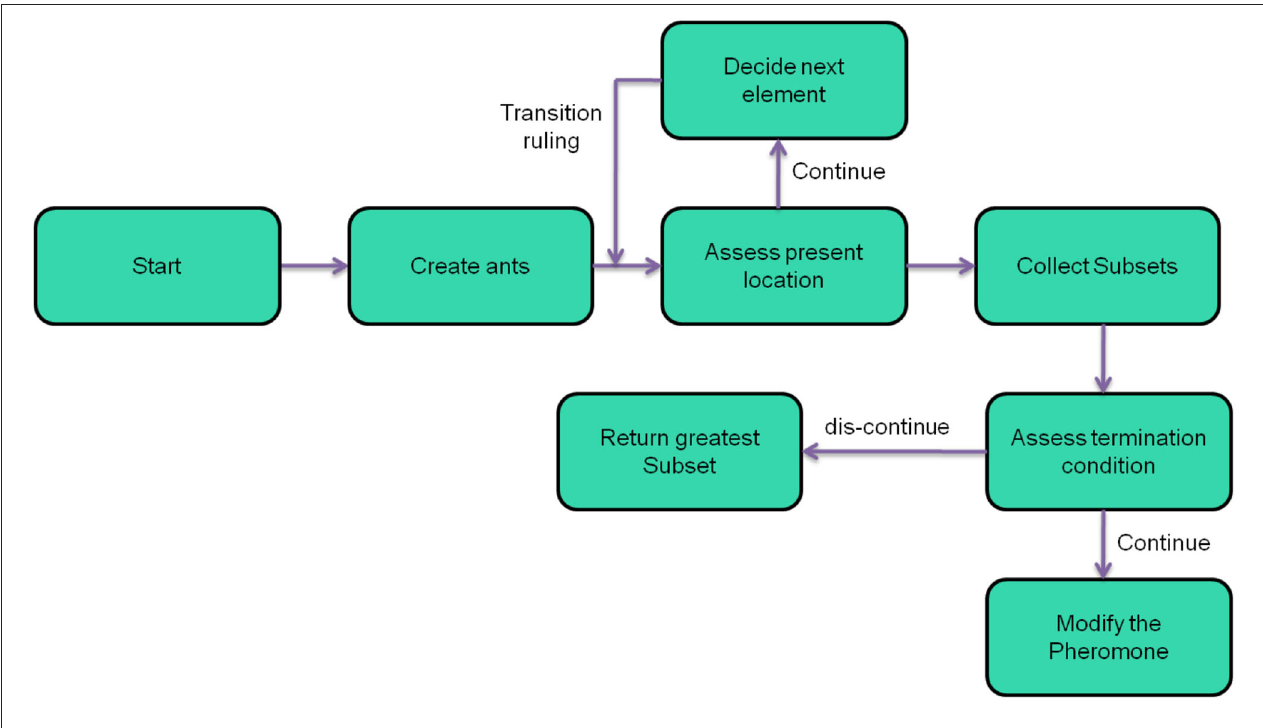
FIGURE 5 | Procedure of MG-ACO.